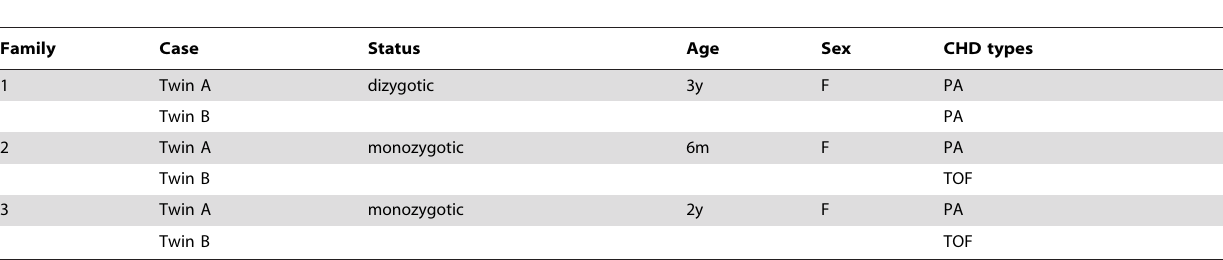
Table 1. Three Chinese pair twins with pulmonary atresia and/or tetralogy of Fallot.